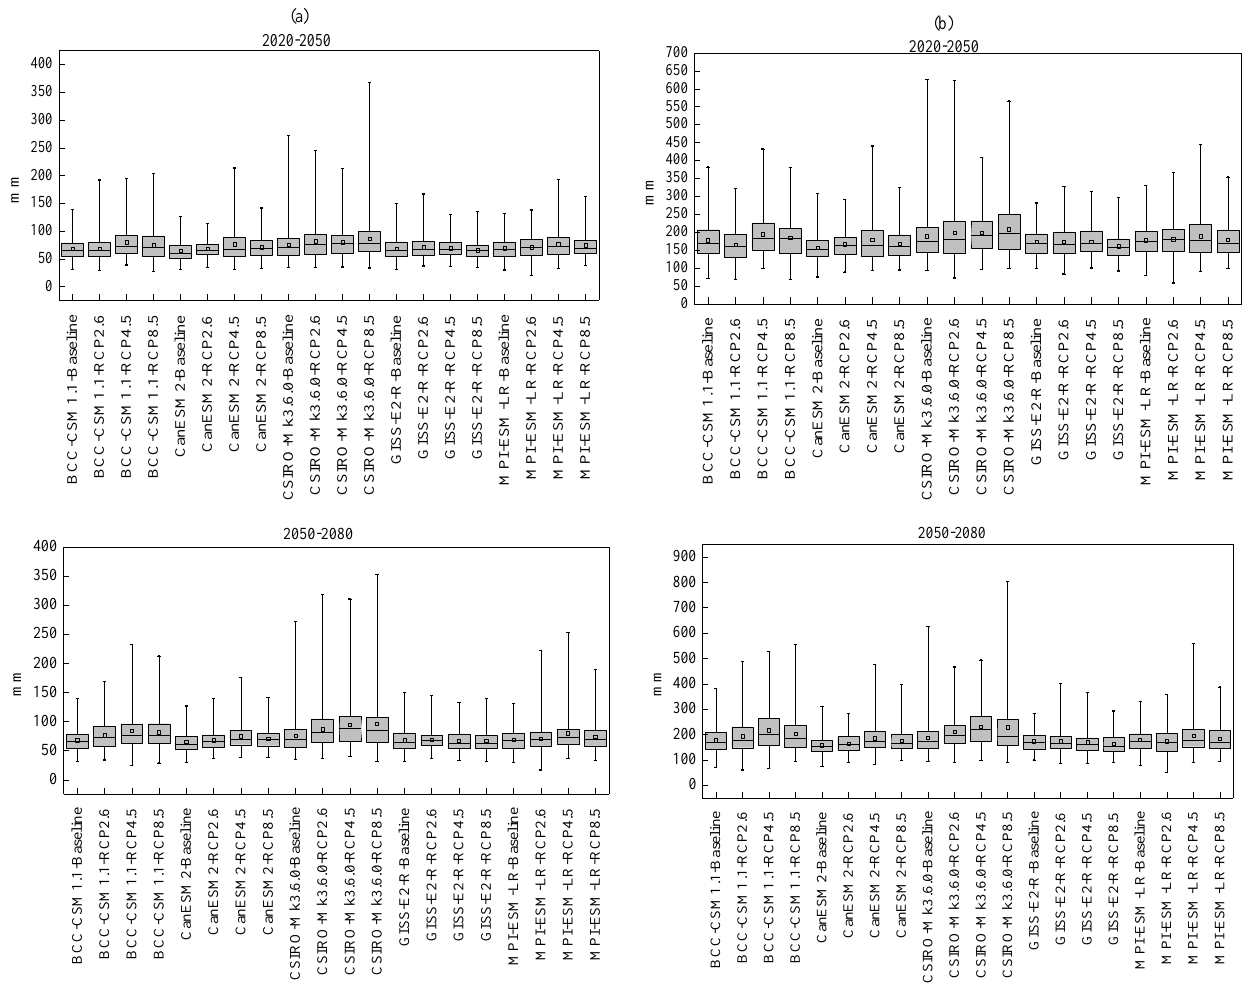
Figure 5. Uncertainty range of (a) AMX1p and (b) AMX7p under different emission scenarios. Box plots: the central mark is the median; the small square inside the box is the average; the box edges are the 25th and 75th percentiles; the whiskers extend to the 1st and 99th